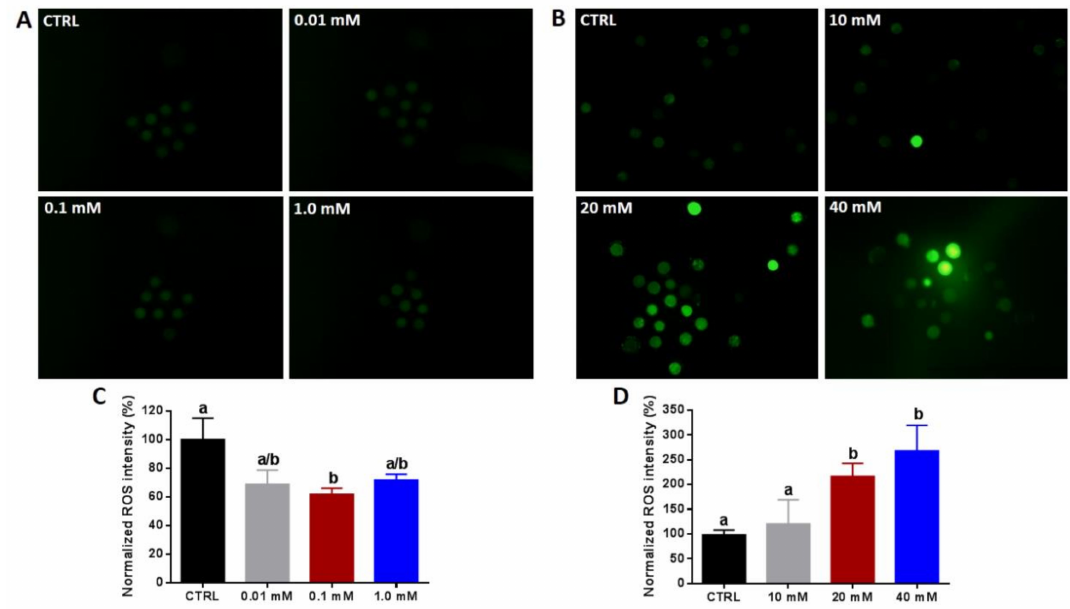
Figure 2. Determination of intracellular reactive oxygen species (ROS) under NAM treatment. 2,7-Dichlorodihydrofluorescein diacetate (H 2 DCFDA) staining of oocytes matured under low ( A ) and high ( B ) NAM concentrations. ( C , D ) The fluorescence intensity of ROS per individual oocyte analyzed by ImageJ. Original magnification 40 × . Superscripts with di ff erent letters indicate statistical